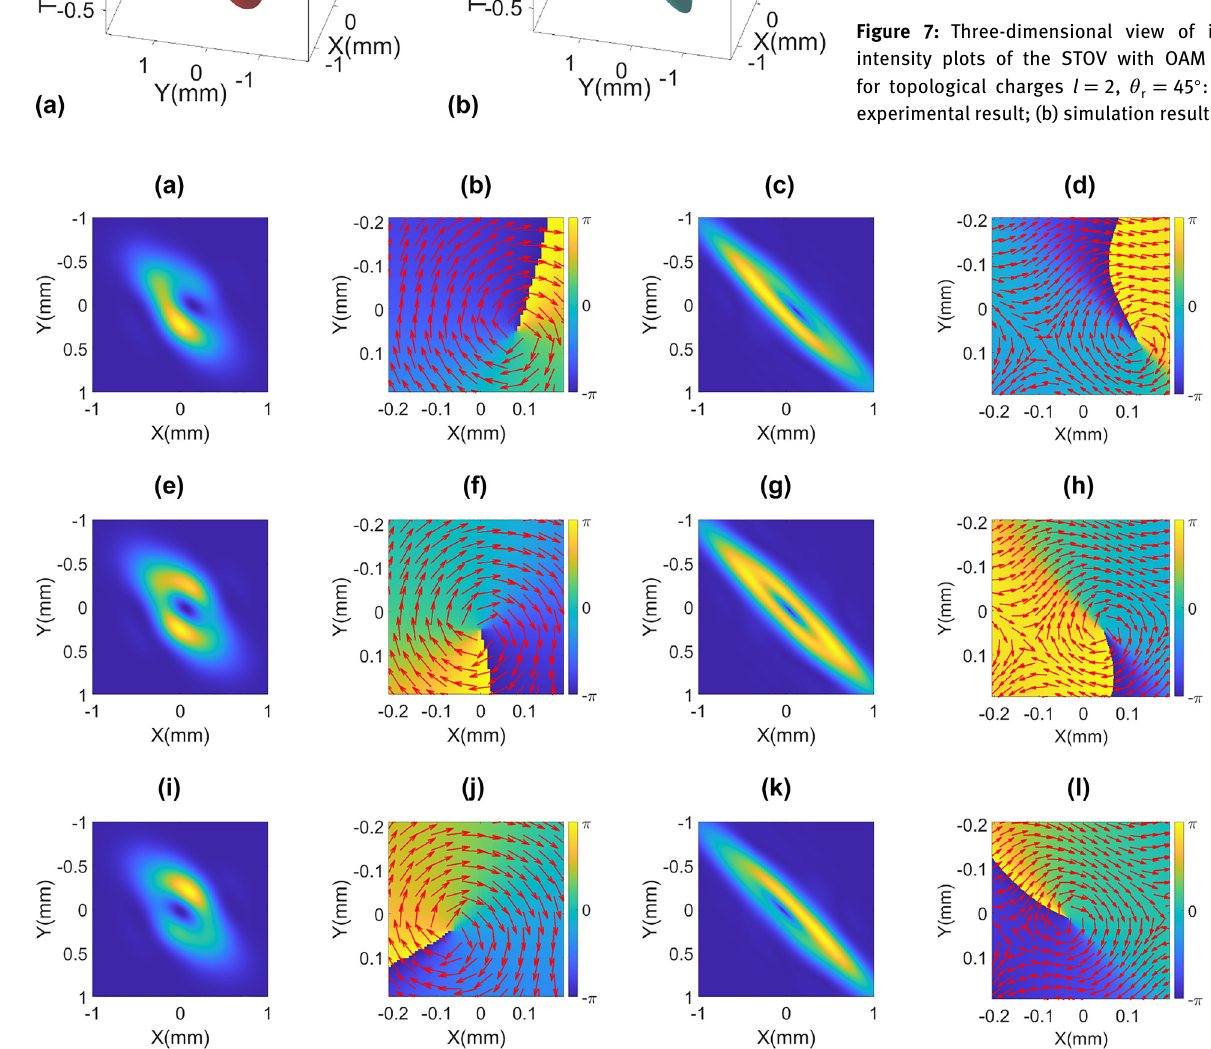
Figure 8: Simulation and experimental results of intensity and unit vector to show Poynting vector direction of transverse planes at different temporal (longitudinal) positions: (a) experimental intensity at t = − 66 . 7 fs; (b) experimental phase and vector plot at t = − 66 . 7 fs; (c) simulation intensity at t = − 66 . 7 fs; (d) simulation phase and vector plot at t = − 66 . 7 fs; (e) experimental intensity at t = 0 fs; (f) experimental phase and vector plot at t = 0 fs; (g) simulation intensity at t = 0 fs; (h) simulation phase and vector plot at t = 0 fs; (i) experimental intensity at t = 66 . 7 fs; (j) experimental phase and vector plot at t = 66 . 7 fs; (k) simulation intensity at t = 66 . 7 fs; (l) simulation phase and vector plot at t = 66 . 7